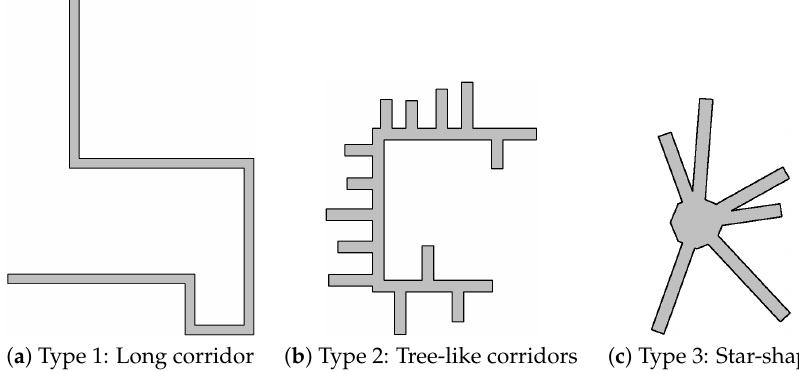
Figure 14. Examples of synthetic data sets used in the